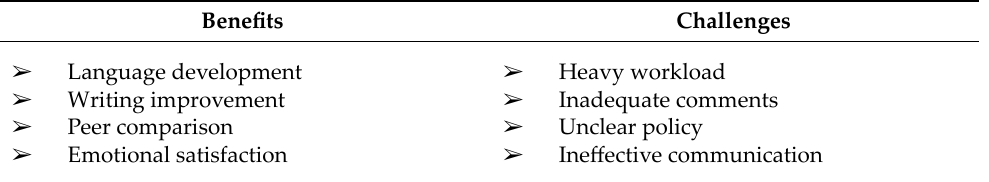
Table 3. Students’ Perceived Benefits and Challenges Related to